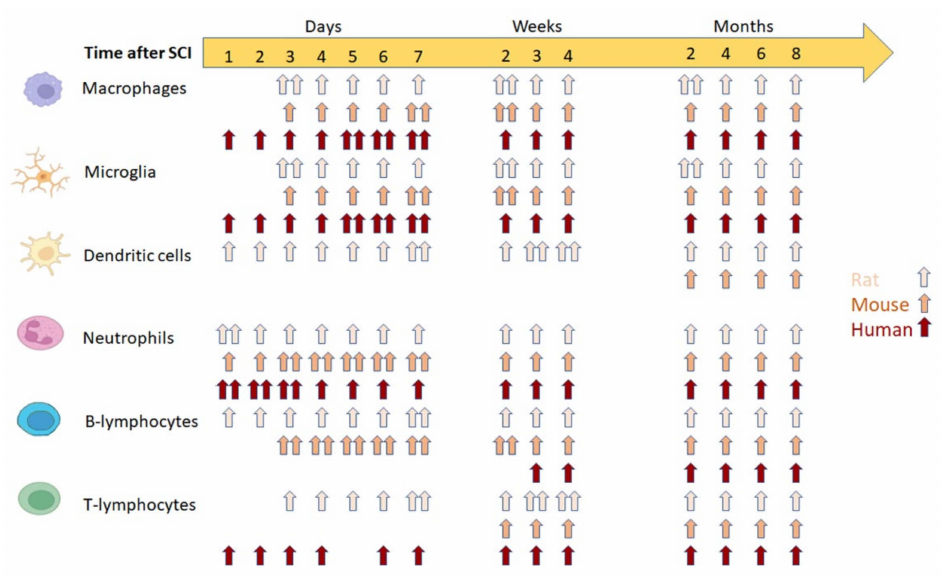
Figure 2. Differences in intraspinal accumulation of immune cells (macrophages, microglia, dendritic cells, neutrophils, B-lymphocytes, and T-lymphocytes) after spinal cord injury in rats, mice, and humans. Presence (one arrow) and peak (two arrows) of immune cells post-SCI in the rat ( ), mouse ( ), and human ( ) Refs.